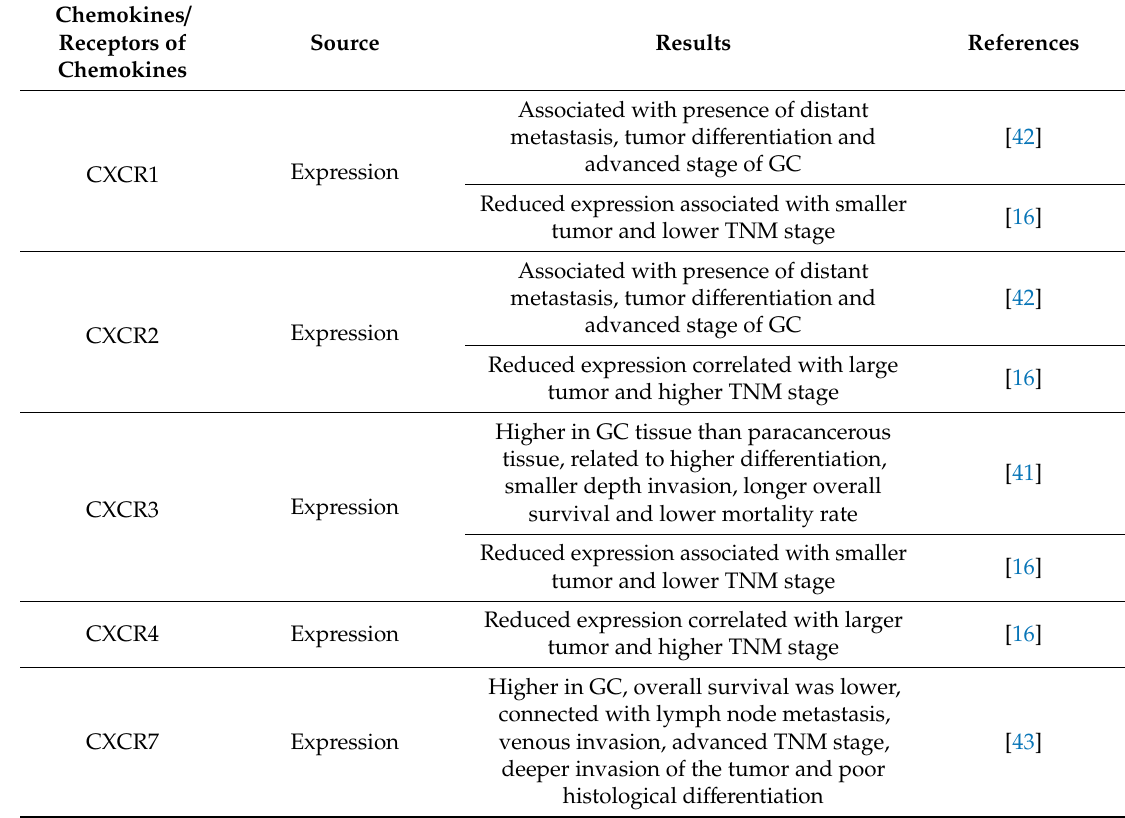
Table 4. The role of chemokine receptors in gastric cancer